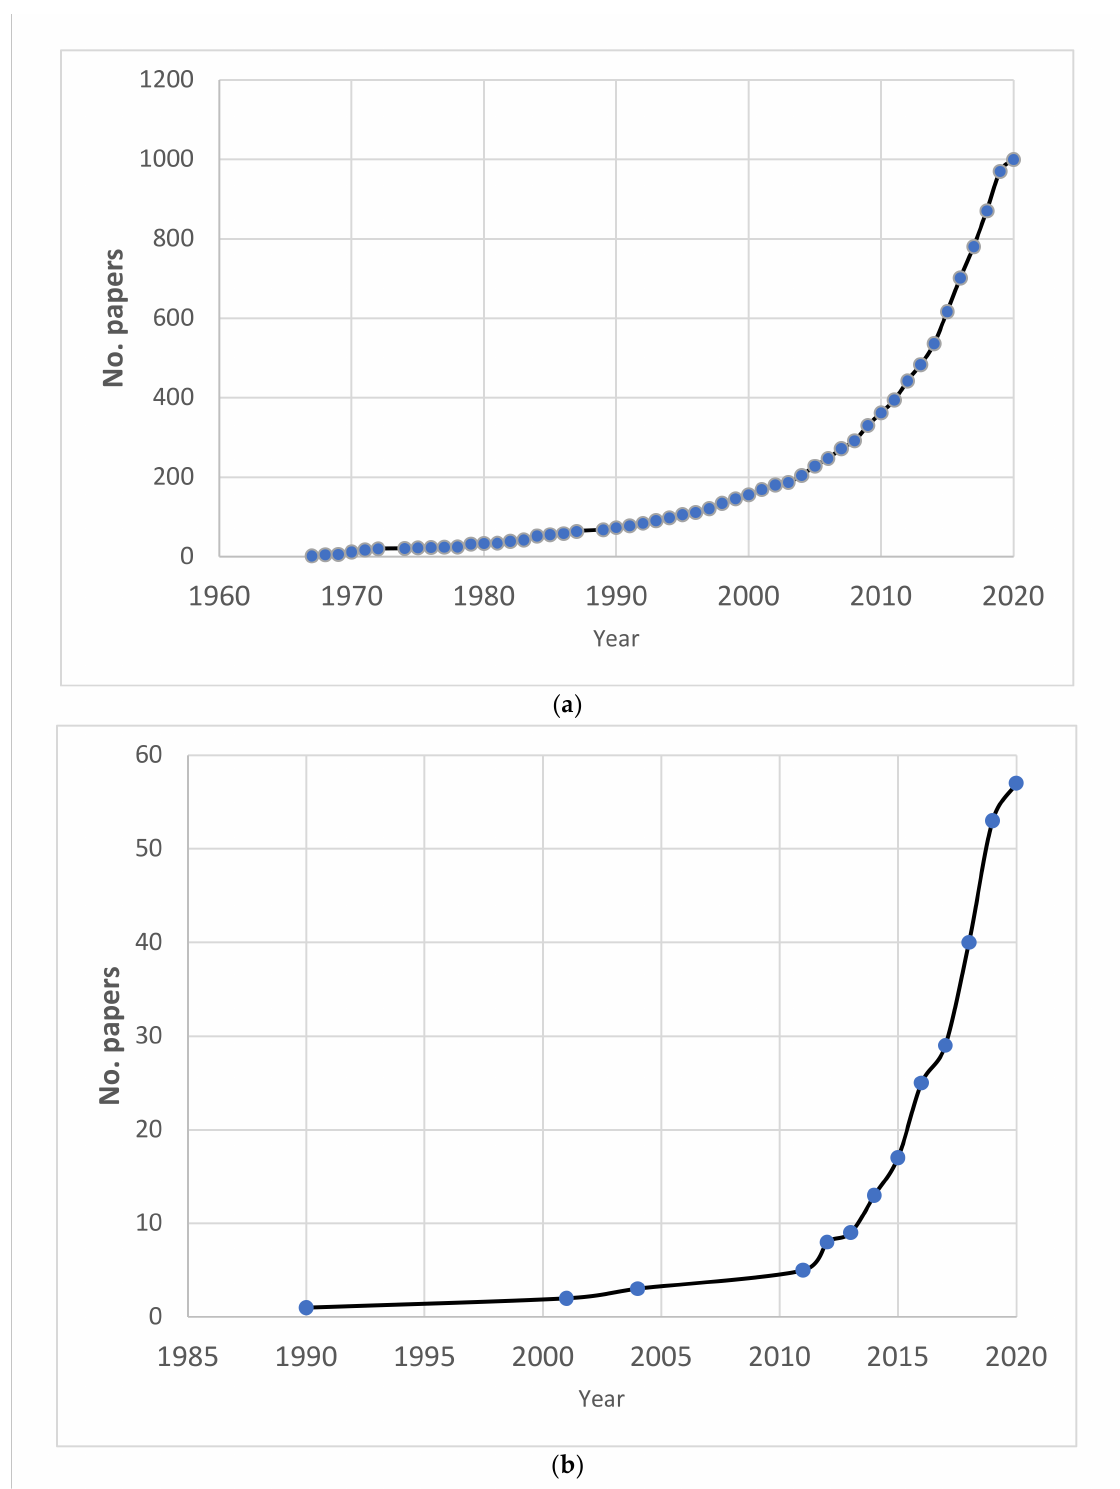
Figure 4. The cumulative number of scientific publications covered in the review (from 1966 to 27 March 2020). ( a ) all records identified in the search ( n = 1001), and ( b ) only those used for analysis (experimental research only, n = 58). Note that the number of papers in 2020 is relatively low due to the review coverage date (through to 27 March